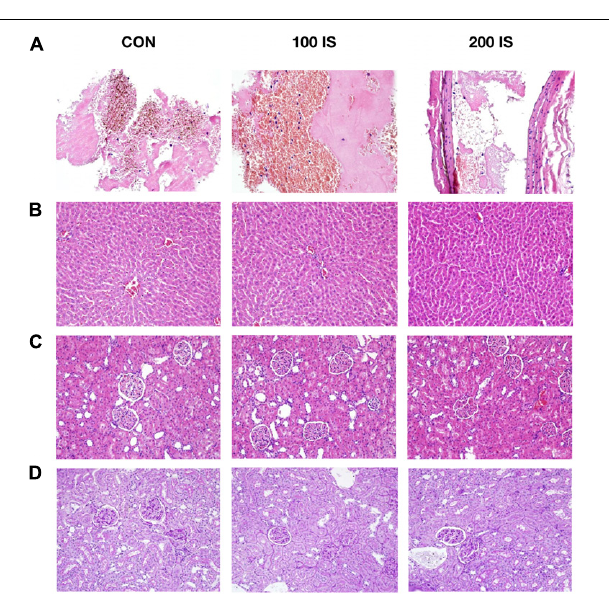
FIGURE 6 | Representative examples of the thrombi (A) , livers (B) , and kidneys (C,D) histology. Samples (A–C) were stained by hematoxylin and eosin (H&E). Samples (D) were stained by periodic acid schiff (PAS). Images (A) were taken using 400 × magnification. Images (B–D) were taken using 200 × magnification. CON, control group; 100 IS, group receiving IS in the dose of 100 mg/kg b.w./day; 200 IS, group receiving IS in the dose of 200 mg/kg b.w./day; IS, indoxyl sulfate.